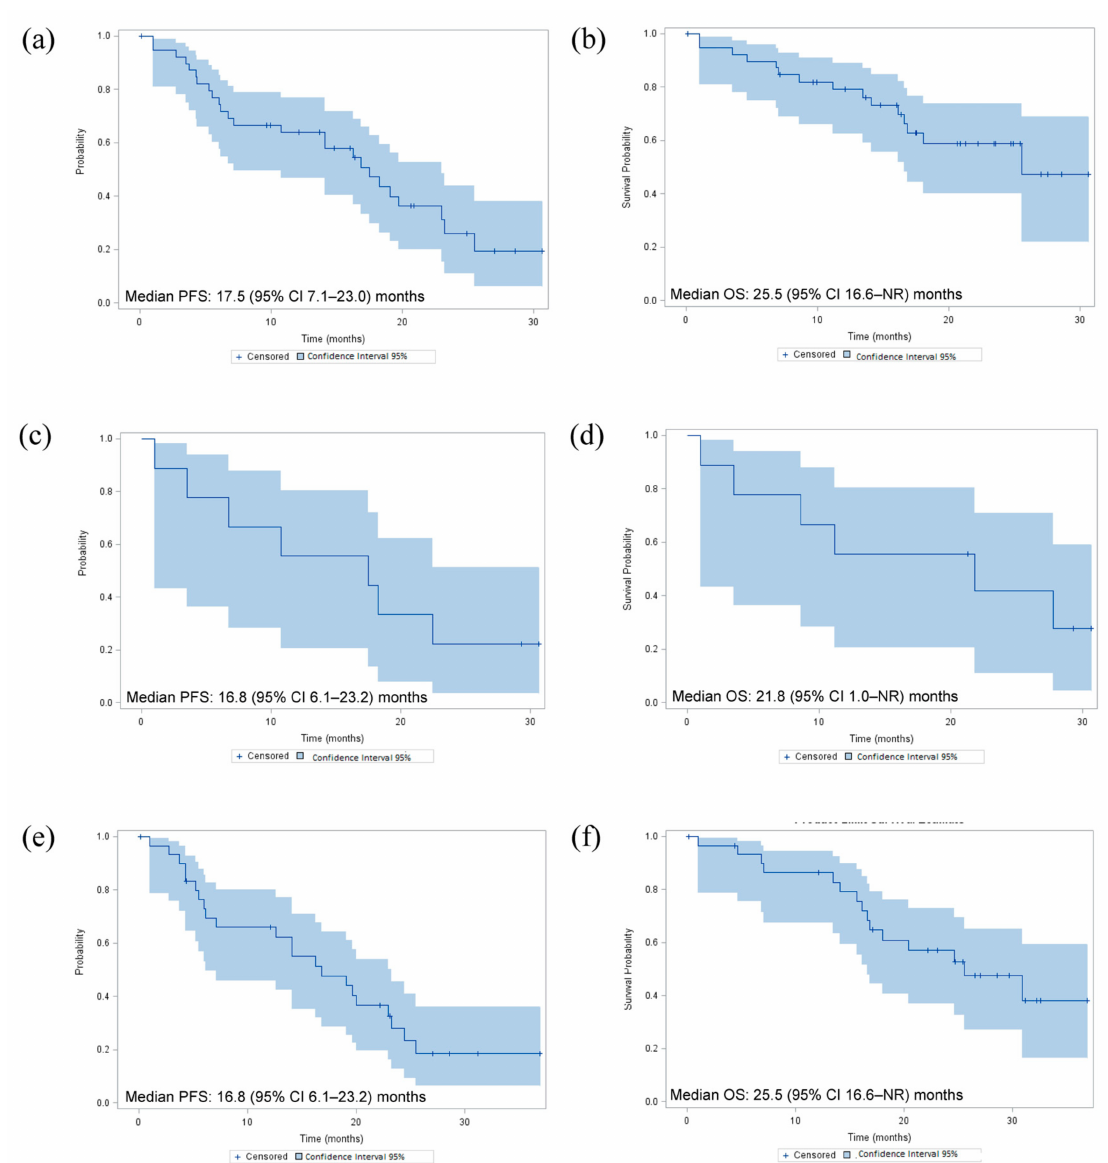
Figure 1. Progression-free survival (PFS) and overall survival (OS) in all patients ( n = 40) treated with dabrafenib plus trametinib combination ( a , b , respectively), in the subgroup of patients ( n = 9) who received dabrafenib plus trametinib as first-line treatment ( c , d ) and in the subgroup of patients ( n = 31) who received dabrafenib plus trametinib as second line or more ( e , f ). NR, not reached. Adverse events led to permanent discontinuation in 7 (18%) patients (heart failure, 2 patients; kidney failure, 1; cytolytic hepatitis, 1; deterioration of the general condition with arthralgia, 1; unknown, 2), treatment interruption in 8 (20%) and dose reduction in 12